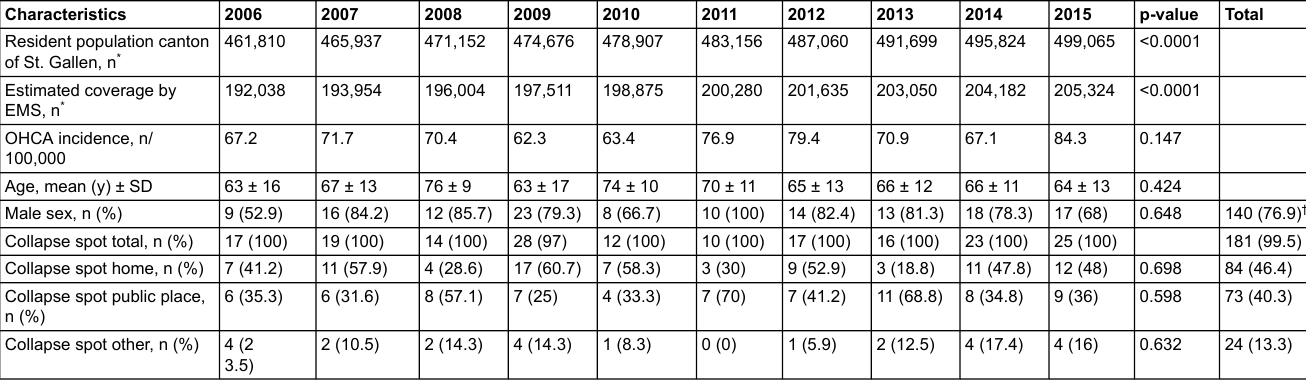
Table 1: Baseline characteristics and collapse spot details.